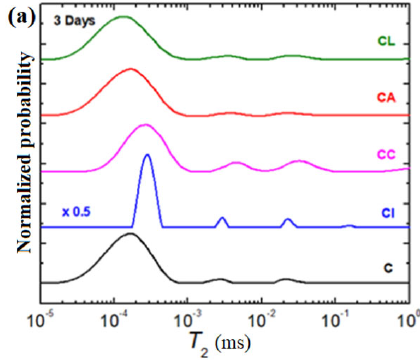
Figure 6. Normalized CPMG echo decay of ( a ) cement and composite ‐ cement materials and ( b ) expired cement and composite ‐ expired cement materials performed at 28 days after their prepara ‐